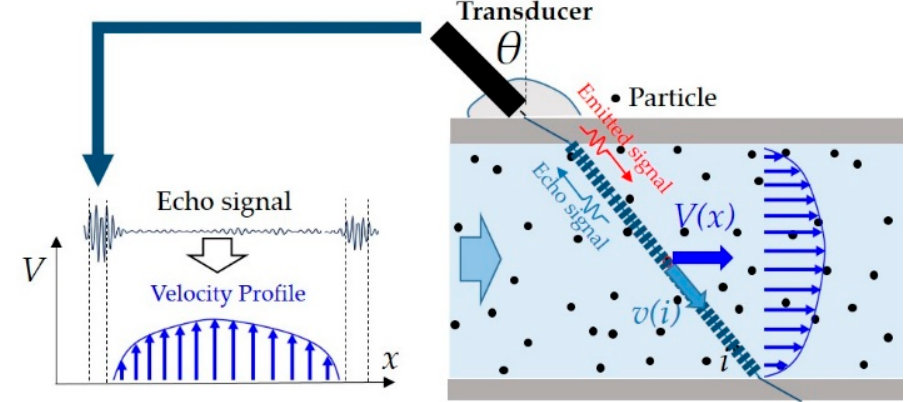
Figure 1. Ultrasonic Velocity Profiler (UVP) measurement configuration, an echo signal and velocity profile reconstruction.